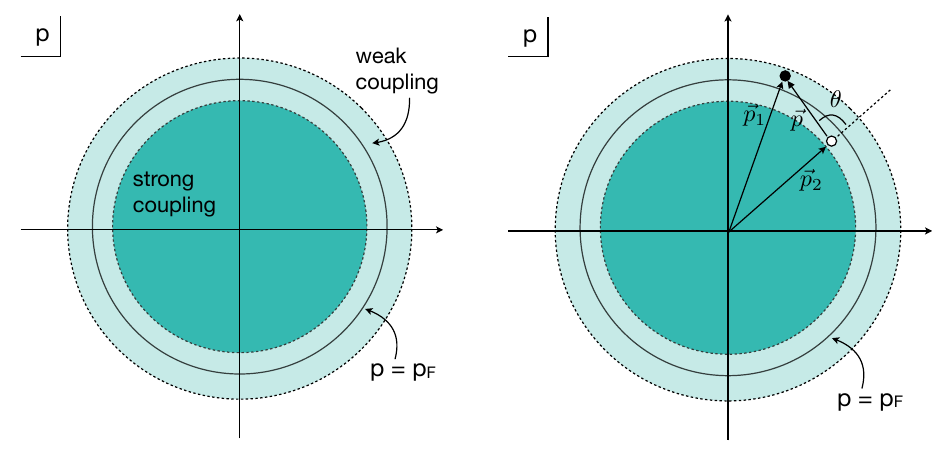
Figure 1 . The momentum space Fermi surface. Left: the weak (light green) and strong (dark green) coupling regions. Right: the particle-hole state consisting of a hole (empty dot) with ~p a particle (full dot) with ~p 1